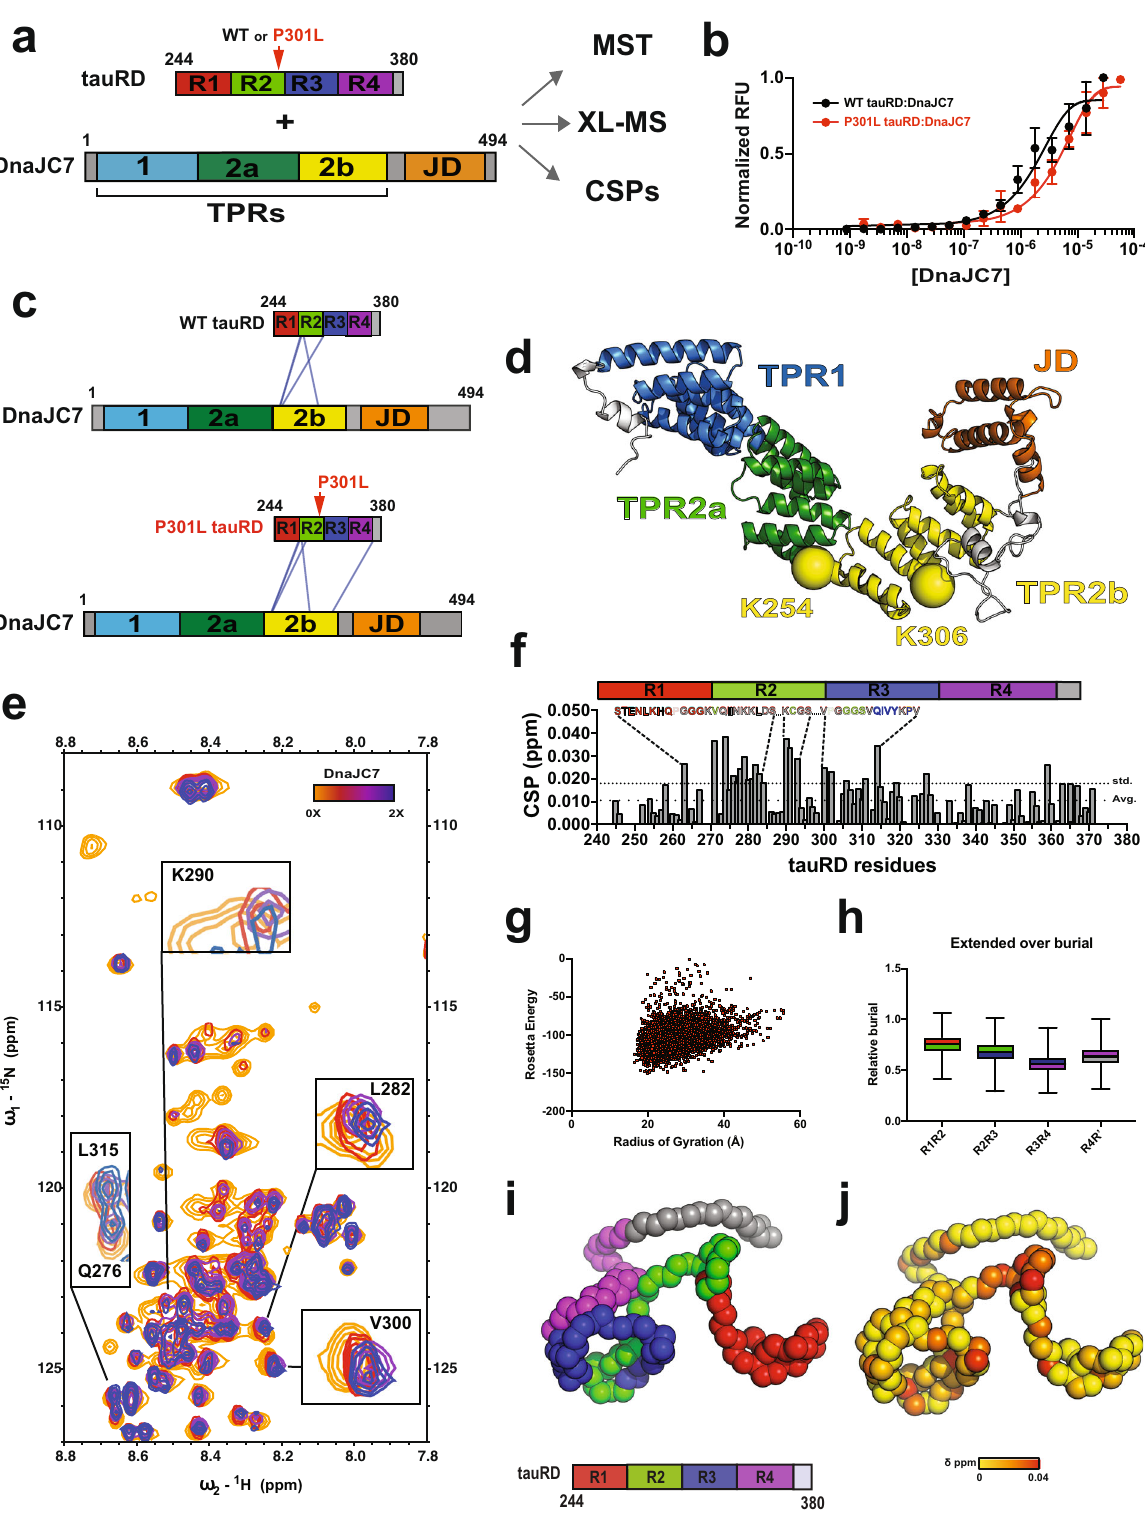
2 and 3 interfaces (herein R2R3) in proximity to the 306 VQI- VYK 311 amyloid motif. Mapping these cross-links onto a homology model of DnaJC7, built using Rosetta 38 , reveals that the K254 and K306 cross-links are located in the peptide-binding groove in TPR2b (Fig. 2d; yellow spheres). While the C-terminal JD and TPR2b domains encode the largest number of lysine residues per domain, we only observe cross-links to TPR2b